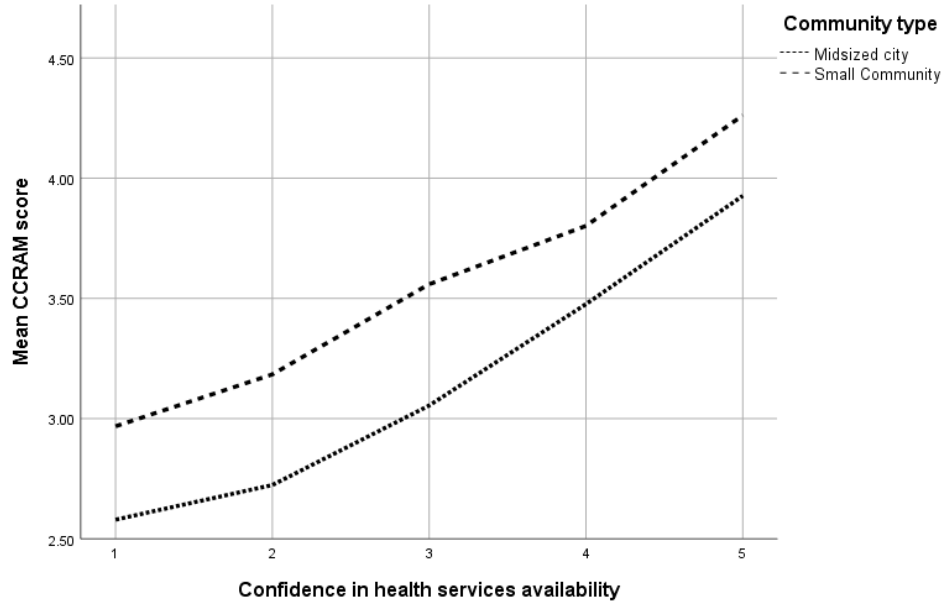
Figure 1. Associations between mean CCRAM scores and confidence in health services availability in accordance with community type.